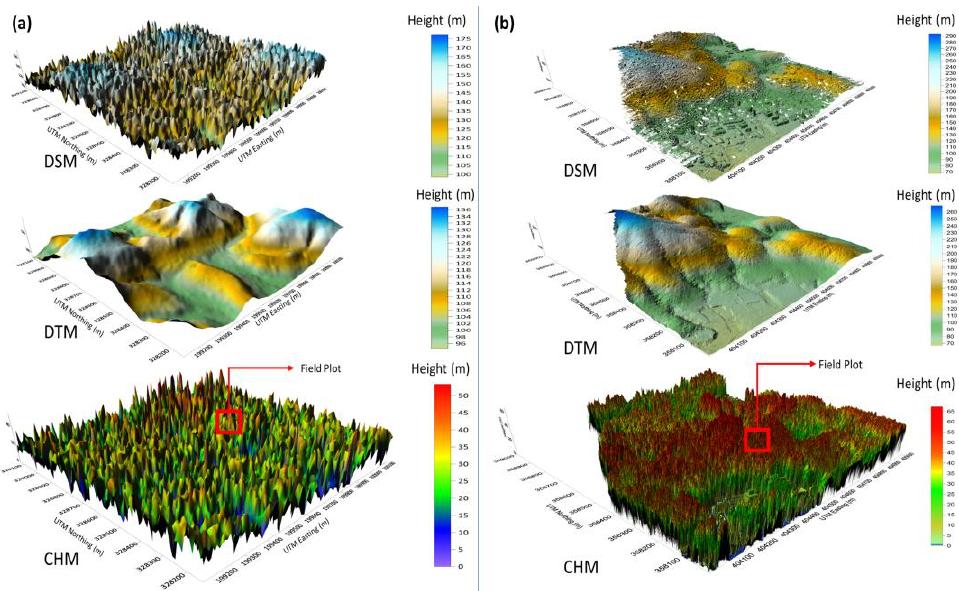
Figure 2. Derivation of the canopy height models (CHMs) as the difference between the digital surface model (DSM) and digital terrain model (DTM) for ( a ) PFR site and ( b ) FRIM site.